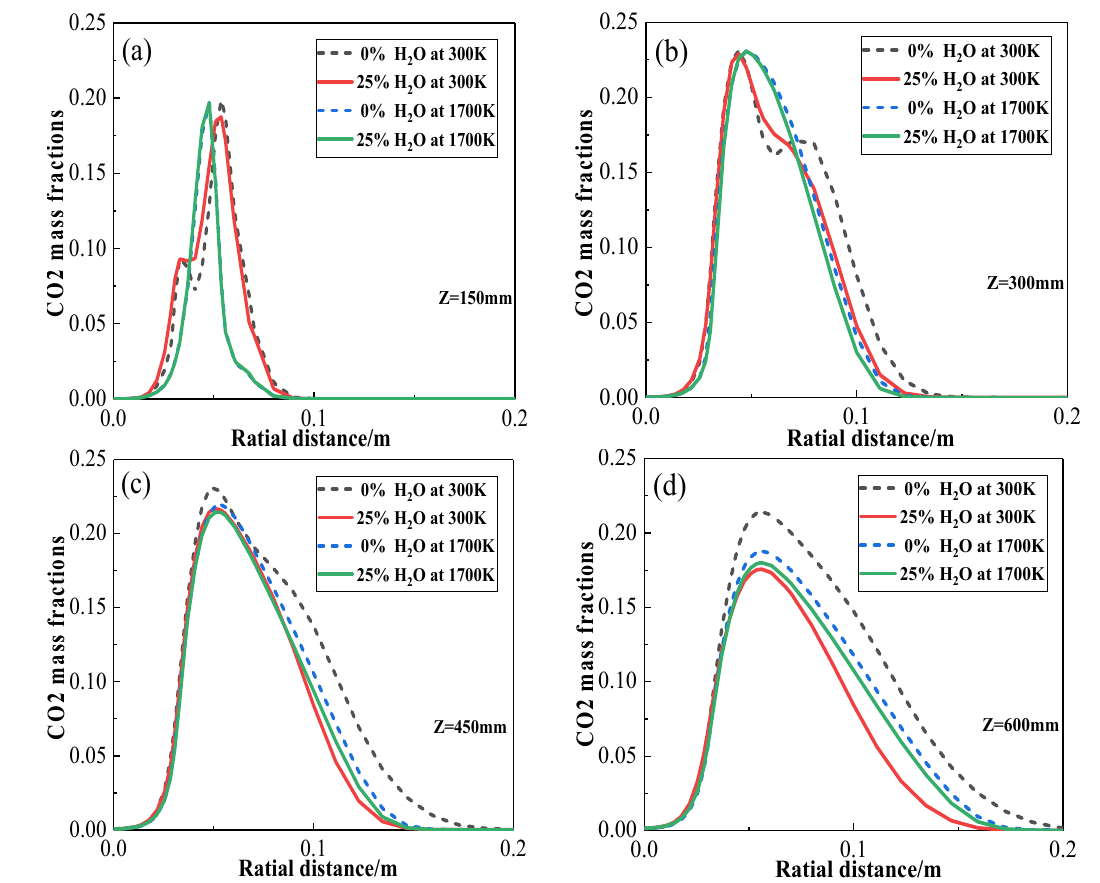
Figure 17. Radial distribution of the CO 2 mass fraction at different positions from the spray gun outlet at 300 and 1700 K: ( a ) Z = 150 mm, ( b ) Z = 300 mm, ( c ) Z = 150 mm, and ( d ) Z = 600 mm.